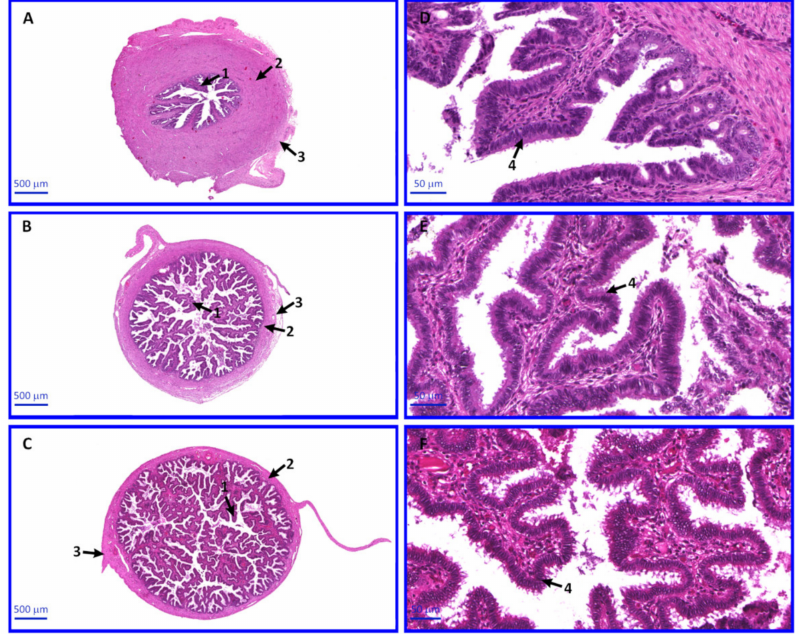
Figure 10. Photomicrograph representing particular segments of porcine oviduct. ( A )–the isth- mus, ( B )–the ampulla, ( C )–the infundibulum, ( D – F )–mucosal folds lined with simple columnar ciliated epithelium. Arrows: 1–mucosal folds, 2–muscular layer, 3–serosa, 4–simple columnar ciliated